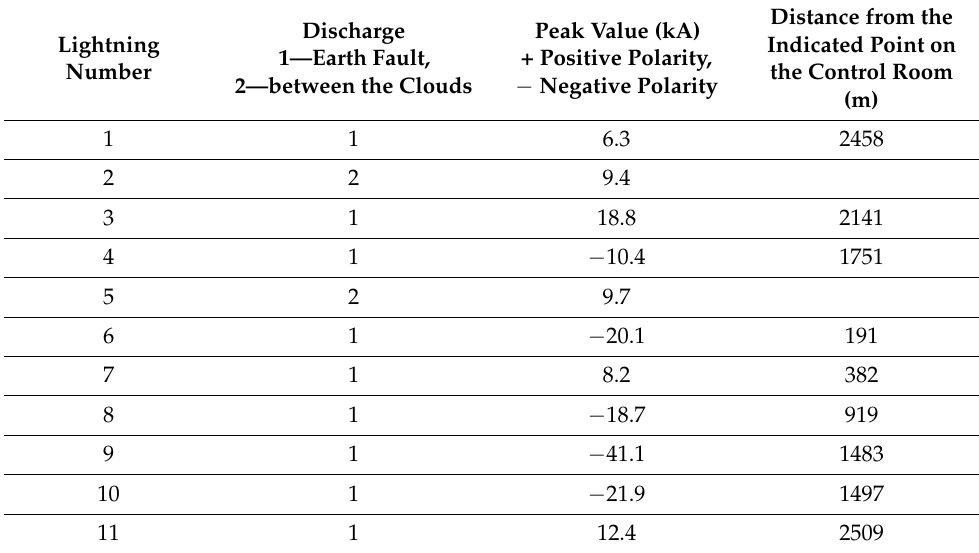
Table 1. Recorded lightning discharges closest to the analyzed structure